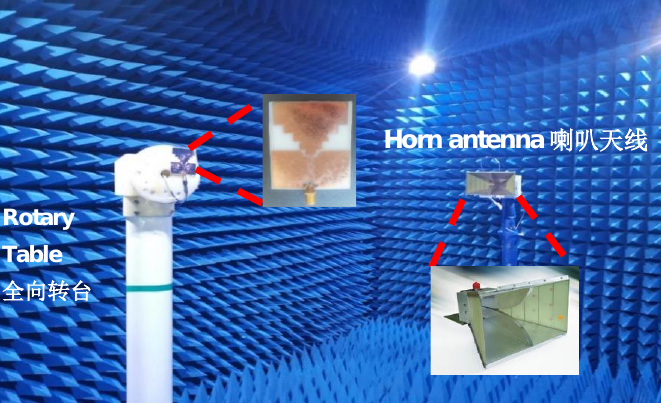
Figure 11. Anechoic chamber antenna physical test diagram.